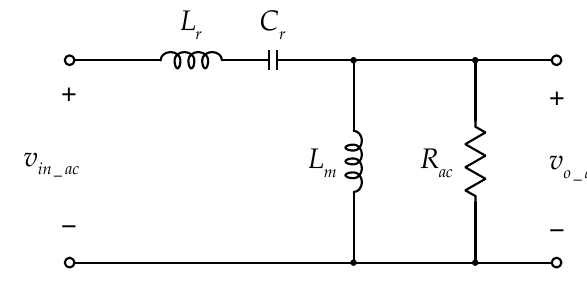
Figure 8. Equivalent resonant circuit [36].